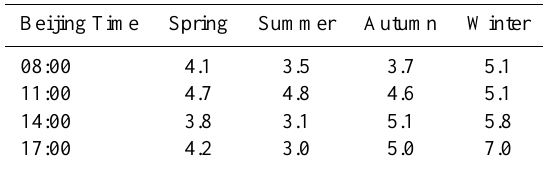
Table 3. Average tropospheric NO 2 VCDs (in units of 10 16 moleculescm − 2 ) over Beijing for different times of the day and different seasons.